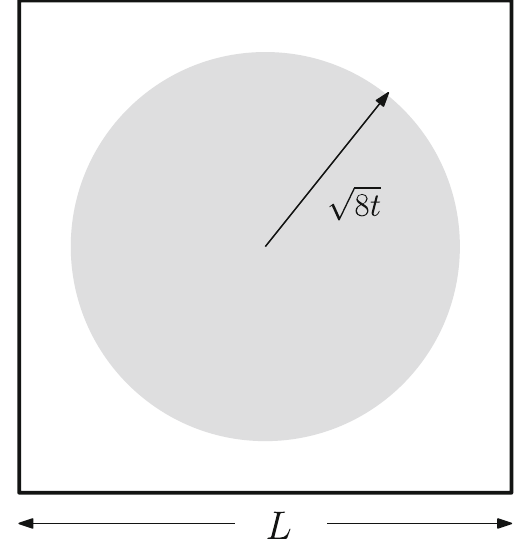
Fig. 1 TheGFcouplinginfinitevolume ¯ g 2 (μ) ismeasuredbycomput- ing the action density of the flow field B μ ( t , x ) smeared over a distance √ 8 t = μ − 1 (see Eq. (2.3)). The renormalization scale μ and the size of the system L are linked by the relation